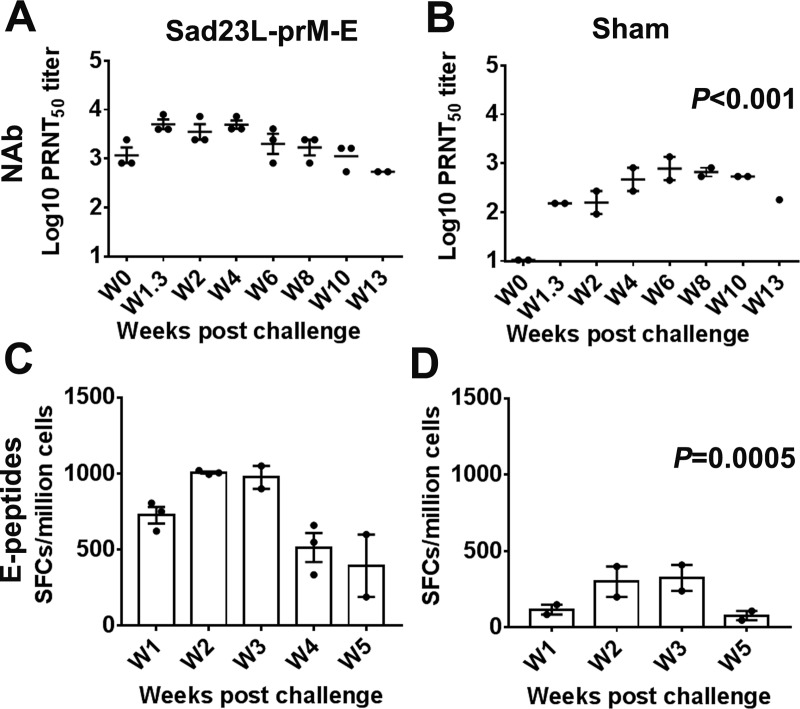
Memory immune response in vaccinated marmosets against ZIKV infection over time.Vaccinated marmosets were tested for secondary neutralizing antibody and T-cell immune response after exposure to ZIKV challenge in comparison with sham marmosets. Titration of serum neutralizing antibody from vaccinated marmosets by PRNT50; (A) in vaccinated animals, (B) in control unvaccinated animals. Measurement of IFN-γ secreting T cell response of PBMCs to E peptides by ELISpot; (C) in vaccinated marmosets, (D) in non-vaccinated sham marmosets. The number of IFN-γ spot forming cells (SFCs) per million PBMCs is calculated in ELISpot. Data are shown as a mean ± SEM (standard errors of means). Statistically significant differences of neutralizing antibody (NAb) or T cell response (E-peptides) between vaccination and sham groups are compared by one-tailed Mann-Whitney U tests, and the P values are presented in Fig 5B and 5D, respectively.